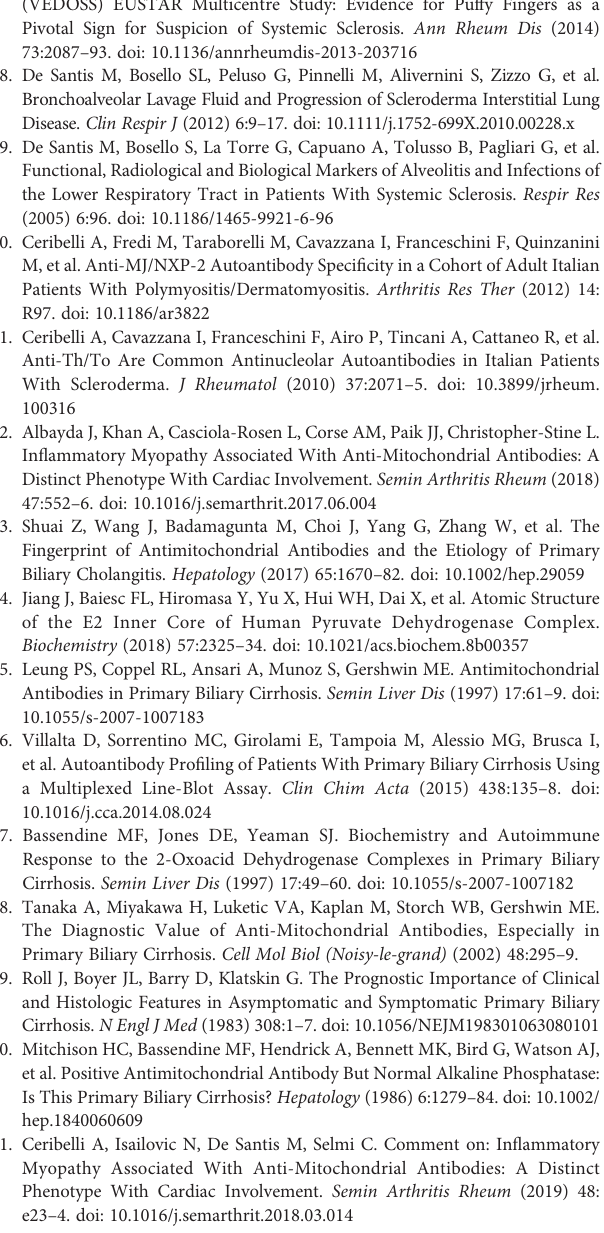
Supplementary Table 1 | ANA patterns recognized beside the cytoplasmic reticular pattern in 44 rheumatic patients with different diagnosis as described. All the numbers are shown in the total lane are shown as % and absolute number in brackets. ACA, anti-centromere antibodies; ANA, anti-nuclear antibodies; DM, dermatomyositis; PM, polymyositis, SSc, scleroderma, systemic sclerosis; UCTD, undifferentiated connective tissue